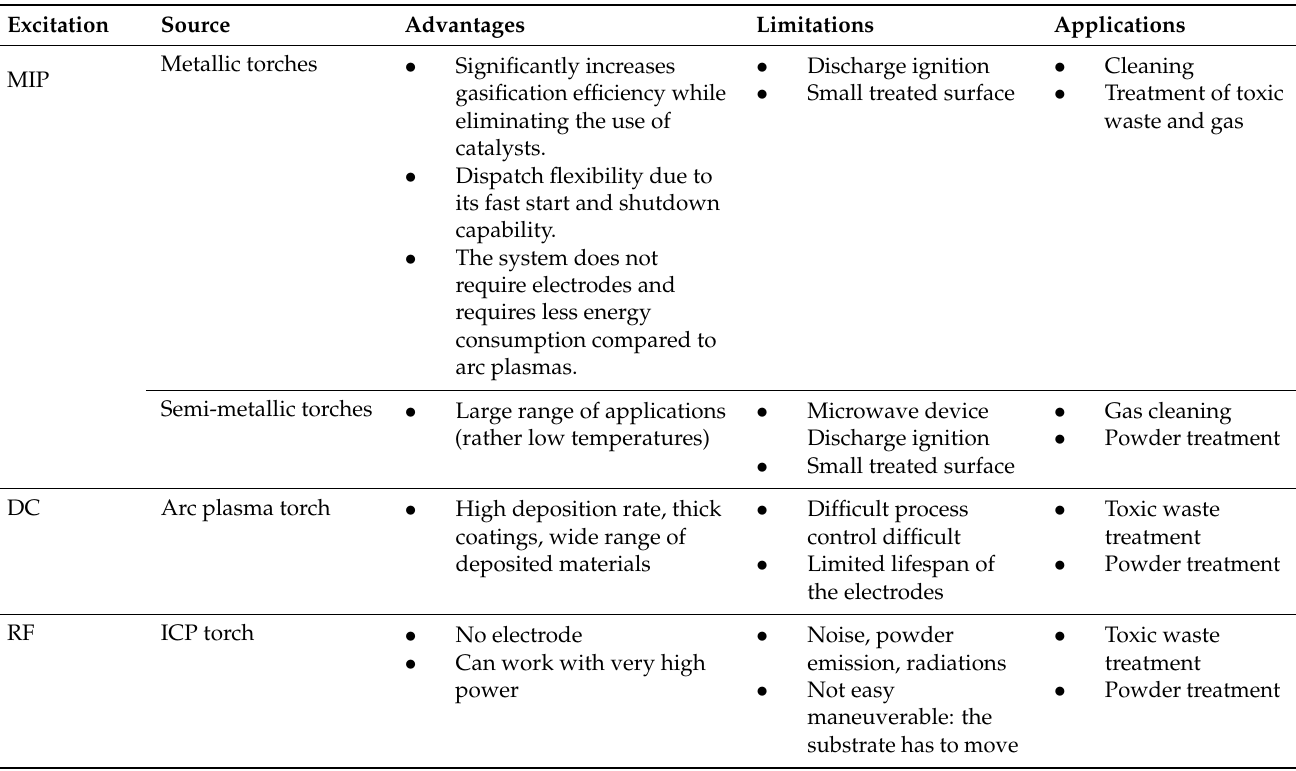
Table 3. Features of specific plasma